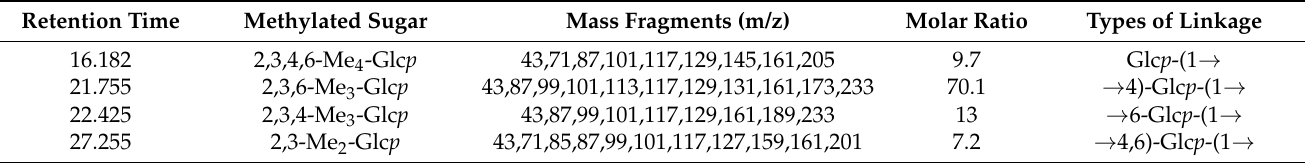
Table 1. Methylation analysis of